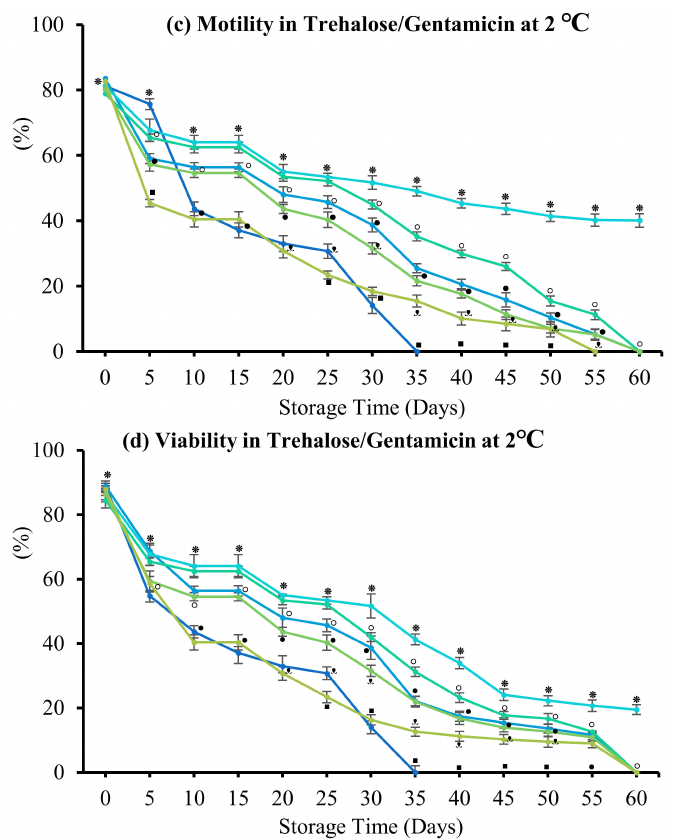
Figure 7. Effect of trehalose on spotted halibut ( Verasper variegatus ) sperm stored in Stein’s solution Figure 4. Effect of gentamicin (G) on the sperm of spotted halibut ( Verasper variegatus ) stored in Stein’s solution for 60 days at 2 °C. ( a ) Motility (%), ( b ) viability Figure 4. Effect of gentamicin (G) on the sperm of spotted halibut ( Verasper variegatus ) stored in Stein’s solution for 60 days at 2 °C. ( a ) Motility (%), ( b ) viability Figure 4. Effect of gentamicin (G) on the sperm of spotted halibut ( Verasper variegatus ) stored in Stein’s solution for 60 days at 2 °C. ( a ) Motility (%), ( b ) viability Figure 4. Effect of gentamicin (G) on the sperm of spotted halibut ( Verasper variegatus ) stored in Stein’s solution for 60 days at 2 °C. ( a ) Motility (%), ( b ) viability Figure 4. Effect of gentamicin (G) on the sperm of spotted halibut ( Verasper variegatus ) stored in Stein’s solution for 60 days at 2 °C. ( a ) Motility (%), ( b ) viability (1:4) + neomycin (N) or gentamicin (G) at 2 ◦ C for 60 days. ( a ) Motility in neomycin (%), ( b ) viability (%), ( c ) average path velocity (VAP; µm/s), ( d ) curvilinear line velocity (VCL; µm/s), ( e ) straight-line velocity (VSL; µm/s), ( f ) linearity (LIN; %), ( g ) straightness (%), ( c ) average path velocity (VAP; µm/s), ( d ) curvilinear line velocity (VCL; µm/s), ( e ) straight-line velocity (VSL; µm/s), ( f ) linearity (LIN; %), ( g ) straightness (%), ( c ) average path velocity (VAP; µm/s), ( d ) curvilinear line velocity (VCL; µm/s), ( e ) straight-line velocity (VSL; µm/s), ( f ) linearity (LIN; %), ( g ) straightness (%), ( c ) average path velocity (VAP; µm/s), ( d ) curvilinear line velocity (VCL; µm/s), ( e ) straight-line velocity (VSL; µm/s), ( f ) linearity (LIN; %), ( g ) straightness (%), ( c ) average path velocity (VAP; µm/s), ( d ) curvilinear line velocity (VCL; µm/s), ( e ) straight-line velocity (VSL; µm/s), ( f ) linearity (LIN; %), ( g ) straightness in neomycin, ( c ) Motility in gentamicin (%), and ( d ) Viability in gentamicin. Symbols ( (STR; %), and ( h ) duration motility (minutes). Symbols ( ⁕ , ⸰ , • , ᵜ , ▪ ) indicate significant differences ( p < 0.05). (STR; %), and ( h ) duration motility (minutes). Symbols ( ⁕ , ⸰ , • , ᵜ , ▪ ) indicate significant differences ( p < 0.05). (STR; %), and ( h ) duration motility (minutes). Symbols ( ⁕ , ⸰ , • , ᵜ , ▪ ) indicate significant differences ( p < 0.05). ) indicate (STR; %), and ( h ) duration motility (minutes). Symbols ( ⁕ , ⸰ , • , ᵜ , ▪ ) indicate significant differences ( p < 0.05). (STR; %), and ( h ) duration motility (minutes). Symbols ( ⁕ , ⸰ , • , ᵜ , ▪ ) indicate significant differences ( p < 0.05). significant differences ( p < 0.05). Control, without antibiotic and antioxidant.